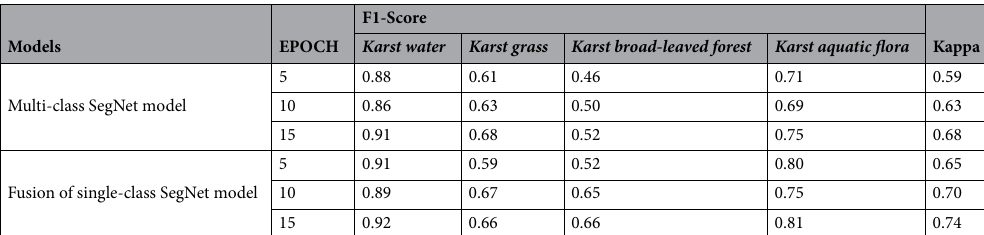
Table 4. Classification accuracies of SegNet models with different EPOCH